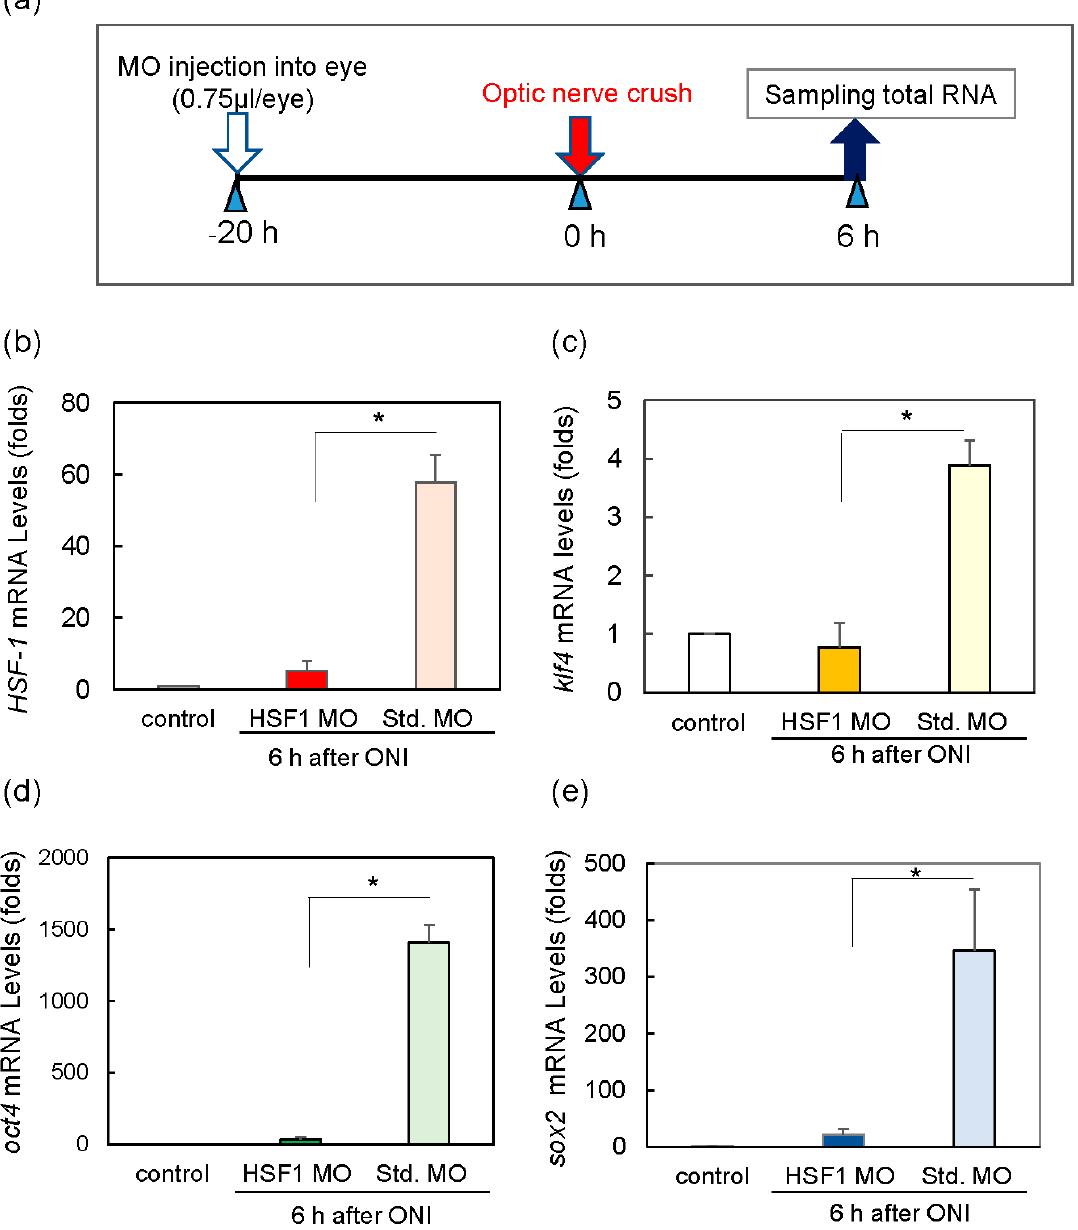
Figure 3. Treatment of HSF1 MO (morpholino) significantly reduced the mRNA expression of Klf4, Oct4, and Sox2 6 h after ONI. ( a ) HSF1 MO or standard MO (Std. MO) was injected intraocularly 20 h before ONI. ( b ) HSF1 MO-treated group suppressed HSF1 mRNA expression compared to the Std. MO-treated group. Under these conditions, the mRNA expression of Klf4 ( c ), Oct4 ( d ), and Sox2 ( e ) was inhibited compared to the control (Std. MO) groups. Five experiments were repeated under each experimental condition. Data are expressed as the mean ± SEM of independent experiments and analyzed by one-way ANOVA, followed by Scheffe’s multiple comparisons. Statistical significance was set at * p < 0.05.